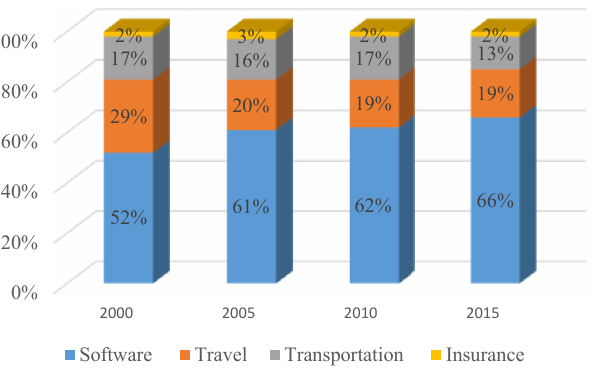
Figure 2. Composition of service